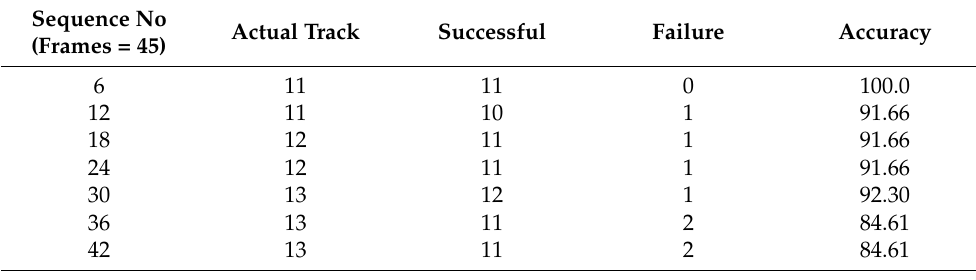
Table 2. Actual human detection and recognition accuracy over UMN dataset.